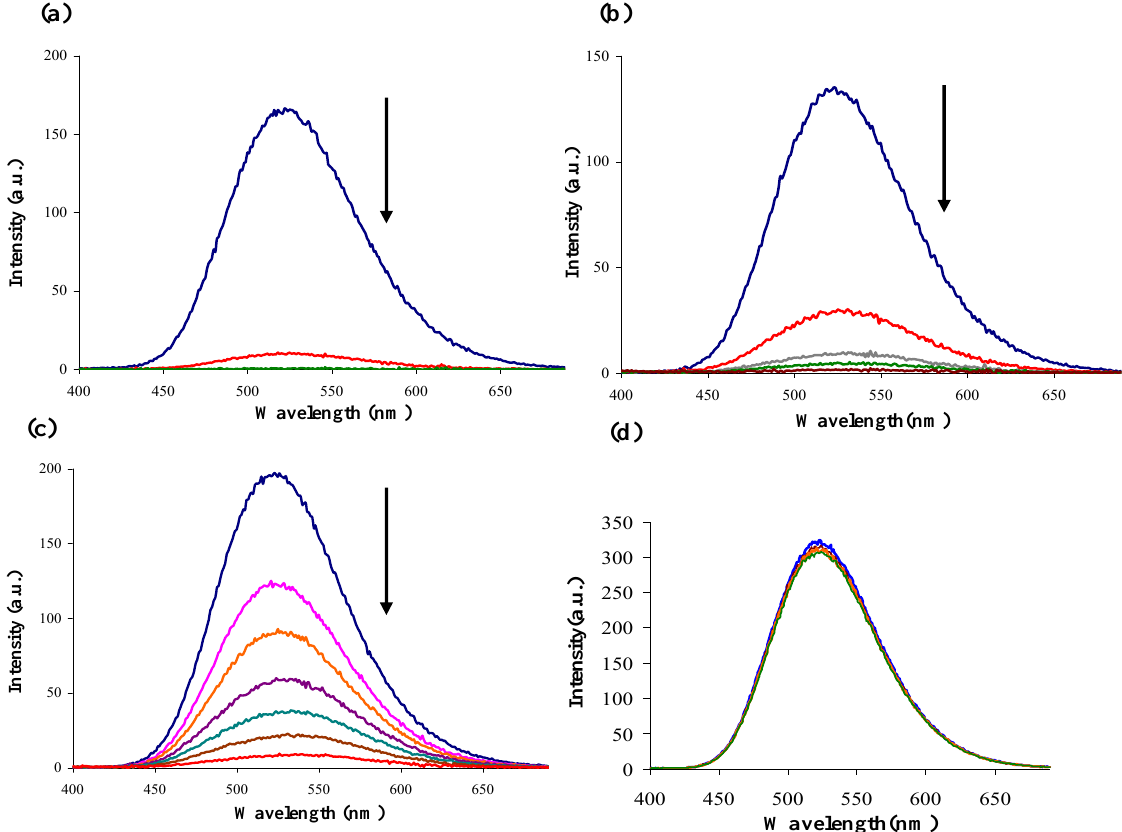
Figure 14. Changes in DQA fluorescence emission spectra upon binding to OPs. (a) titration with ethion, from top to bottom concentration of ethion = 0, 2, 4, 6 μ M; (b) titration with malathion, from top to bottom concentration of malathion = 0, 2, 4, 8 μ M; (c) titration with parathion, from top to bottom concentration of ethion = 0, 2, 4, 6, 8, 10, 12 μ M; and (d) titration with fenthion, with up to 24 μ M of fenthion being added with no change observed. The arrow indicates the direction in which the fluorescence intensity change takes